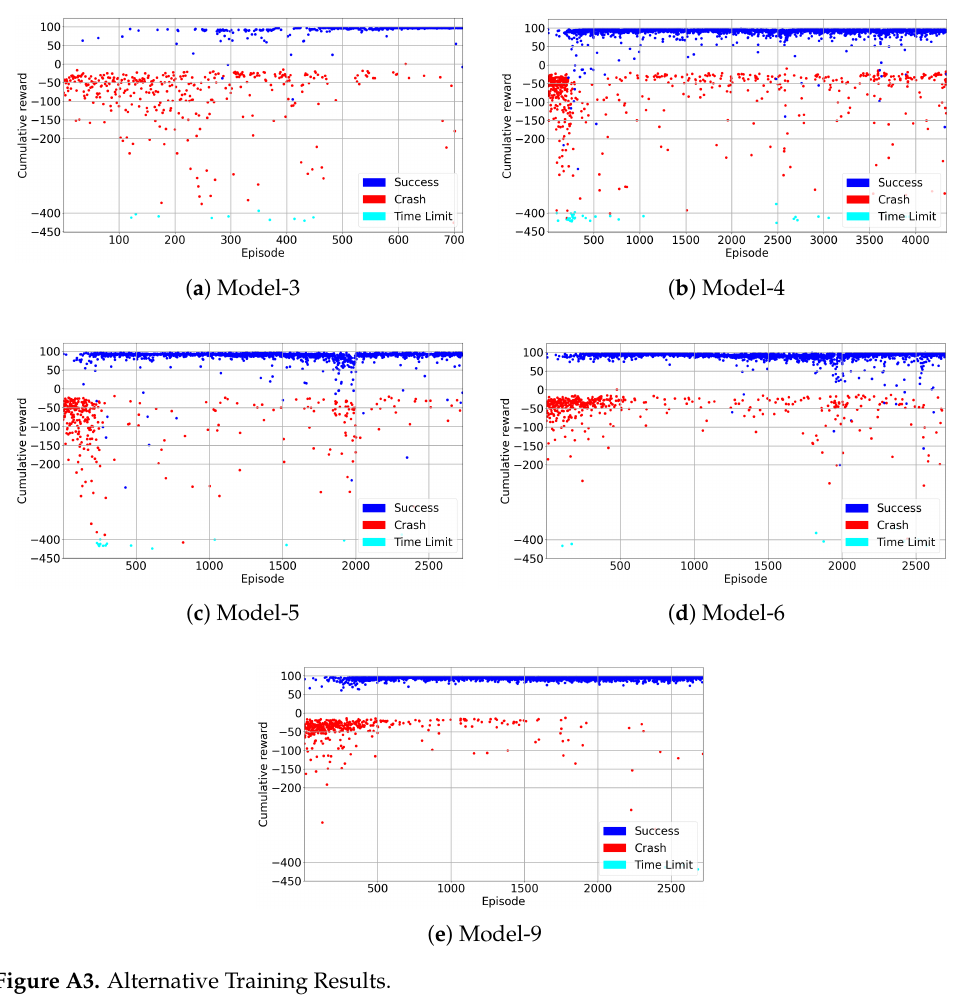
Figure A3. Alternative Training